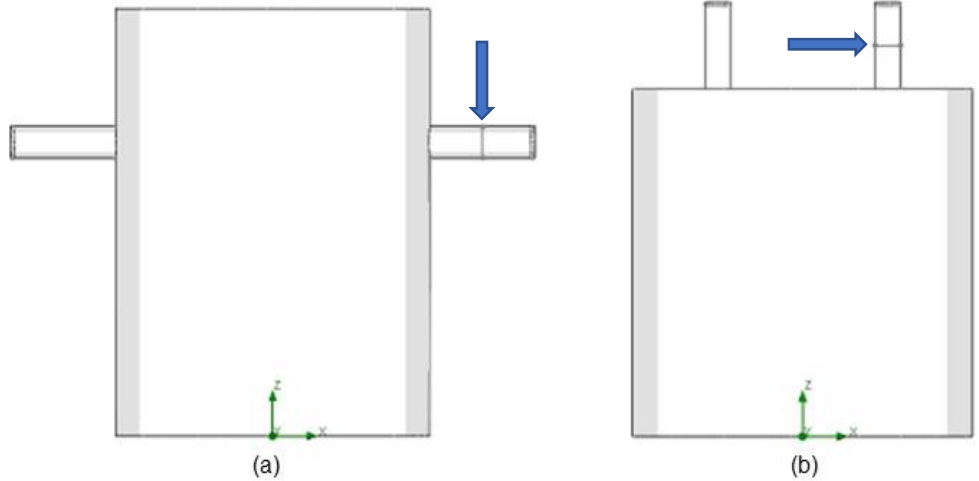
Figure 3. ( a ) Model of geometry of lateral inlet and outlet with line traced to 1 cm from the end of the air outlet tube; ( b ) Model of geometry of upper inlet and outlet with line traced to 1 cm from the end of the air outlet